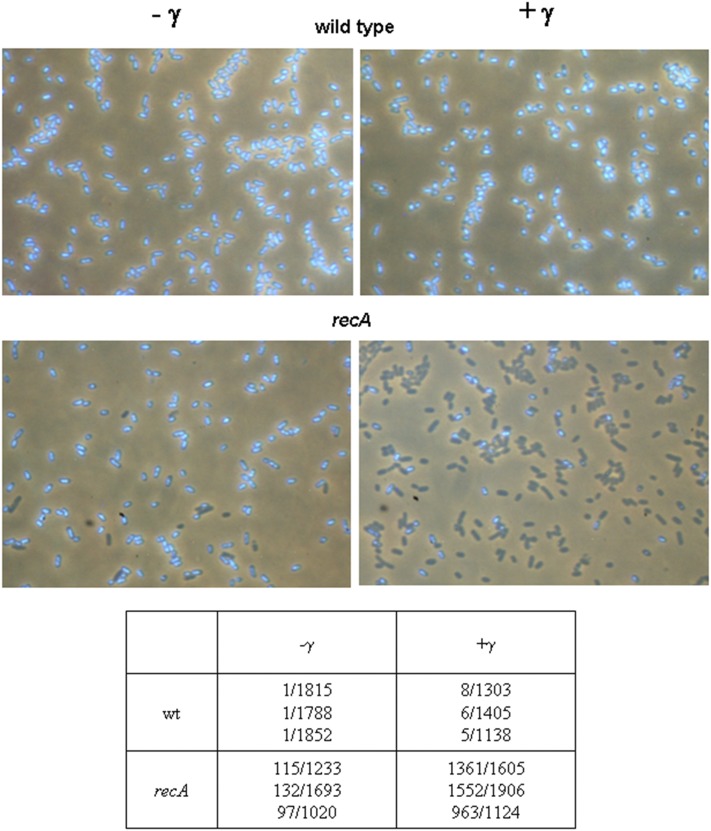
DNA degradation is strictly controlled in wild-type, but not in recA cells. A fraction of anucleate cells was determined in wild-type (AB1157) and recA populations, which were either unirradiated (left side of the panel) or irradiated with 400 Gy of γ-rays and then incubated for 90 min at 37° (right side of the panel). Cells were fixed with osmium tetroxide, their DNA stained with DAPI, and visualized by fluorescence microscopy. An anucleated cell count in an analyzed population from three experiments is represented in a table. DAPI, 4’,6-diamidino-2-phenylindole; wt, wild-type.